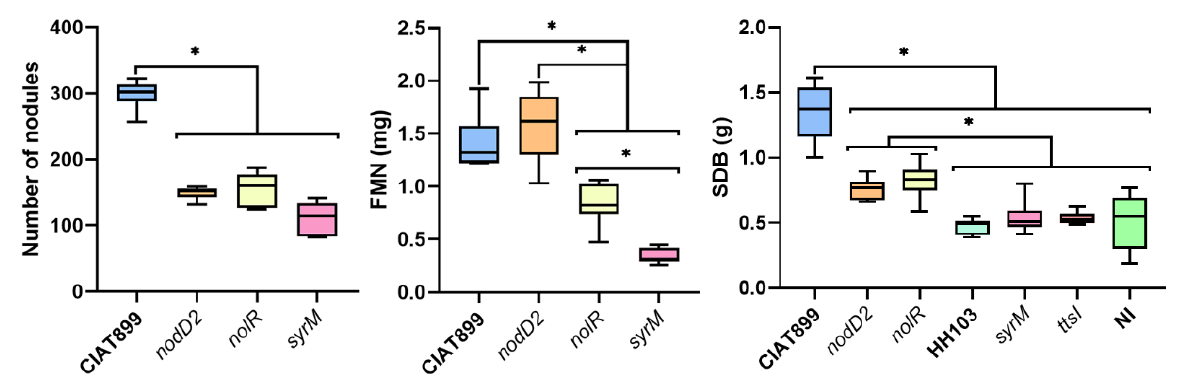
Figure 3. Symbiotic performance of R. tropici CIAT 899, S. fredii HH103 and its nodD2 , nolR , syrM , and ttsI derivatives with Phaseolus vulgaris . FMN, fresh mass of nodules. SDB, stem dry biomass. All treatments were compared to each other following the Mann–Whitney non-parametric test. Significant differences ( α = 0.5%) are denoted by asterisks.